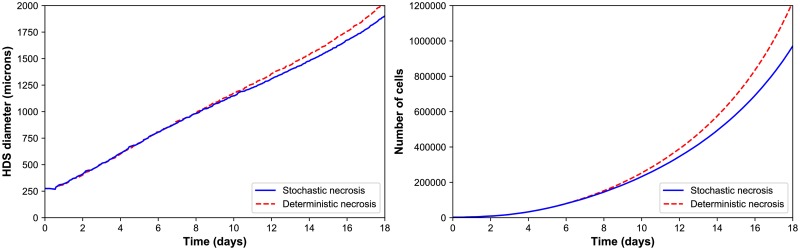
HDS growth.Left: The deterministic and stochastic necrosis models both give approximately linear growth (left), but the HDS with deterministic necrosis model grows faster (∼ 5% difference in diameter at day 18). Right: The HDS with stochastic necrosis has fewer cells than the deterministic model (∼ 26% difference in cell count at day 18), due to its delay in necrosis. The difference in cell count is larger than the difference in tumor diameter because most of the difference lies in the number of necrotic cells, and necrotic cells are smaller than viable cells.